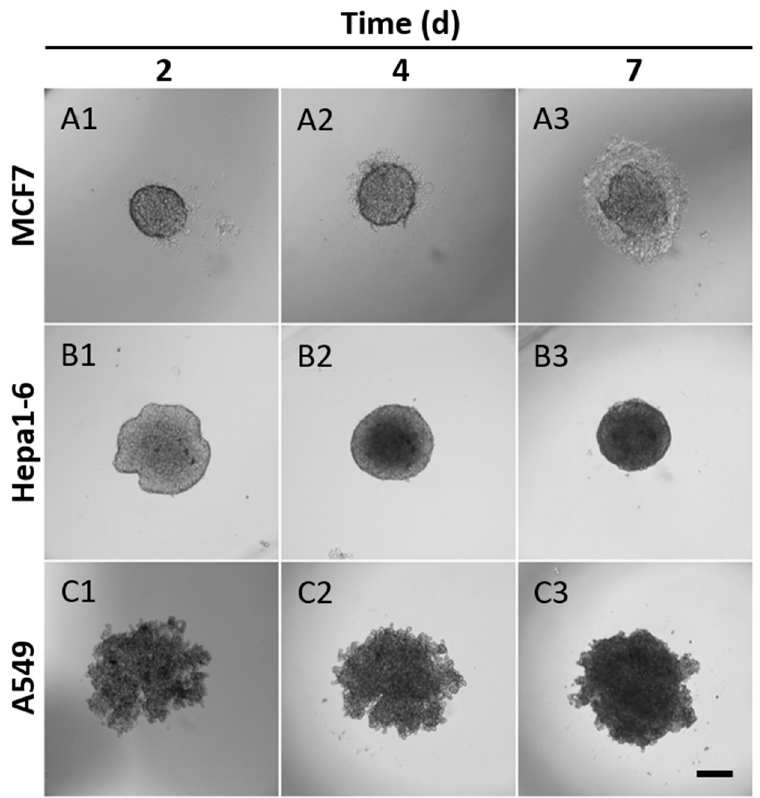
Figure 3. Spheroid formation in Q-serts over time. ( A1 – A3 ) MCF7, ( B1 – B3 ) Hepa1-6 and ( C1 – C3 ) A549 cells were used and monitored over the course of 7 days, 5000 cells seeded, scale bar 200 µm. 1: day 2, 2: day 4, 3: day 7.